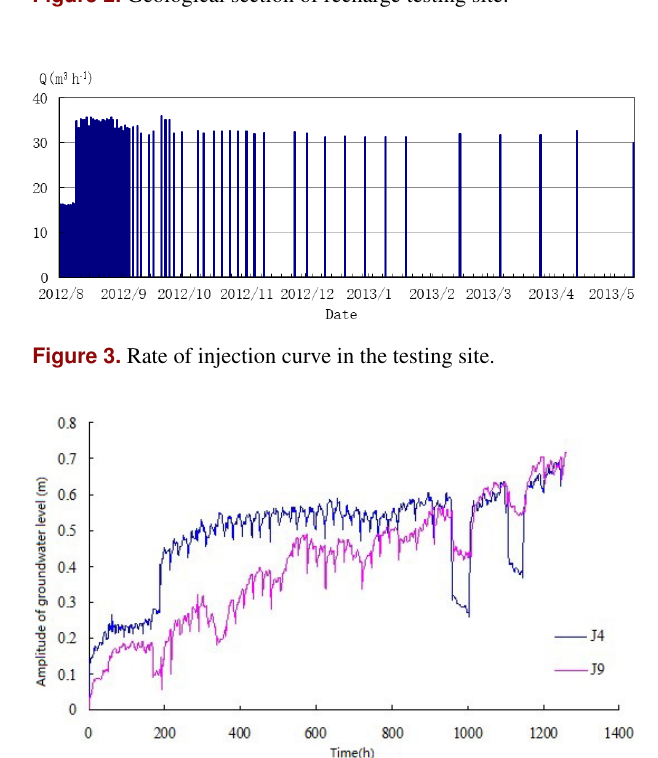
Figure 2. Geological section of recharge testing site.